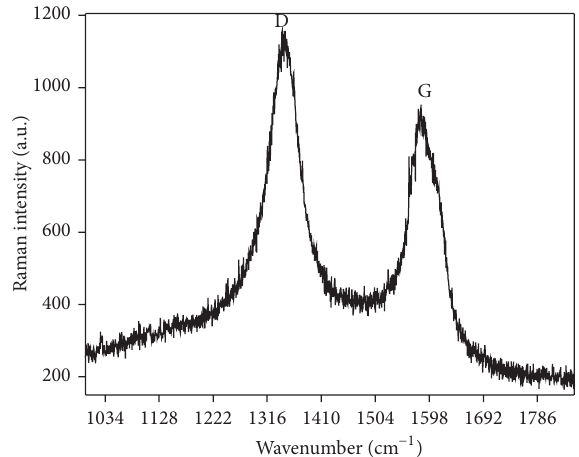
Figure 3: Raman spectrum for the as-grown SnO 2 -CNT composite from 1000 to 1800 cm −1 showing the D and G bands typical of